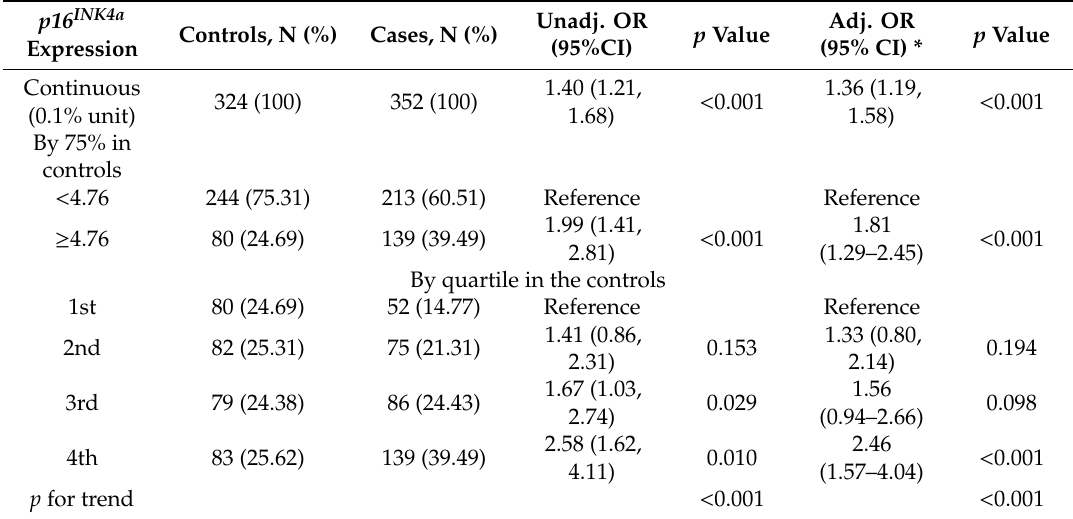
Table 3. Association between P16 INK4a expression and breast cancer risk in the case–control